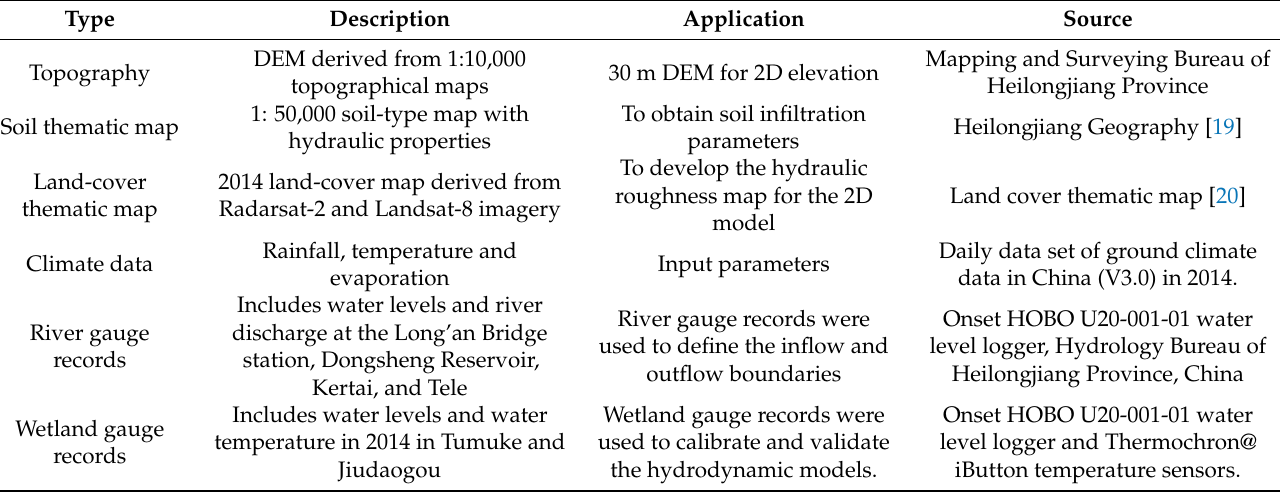
Table 1. Summary of data used in the hydrodynamic models.